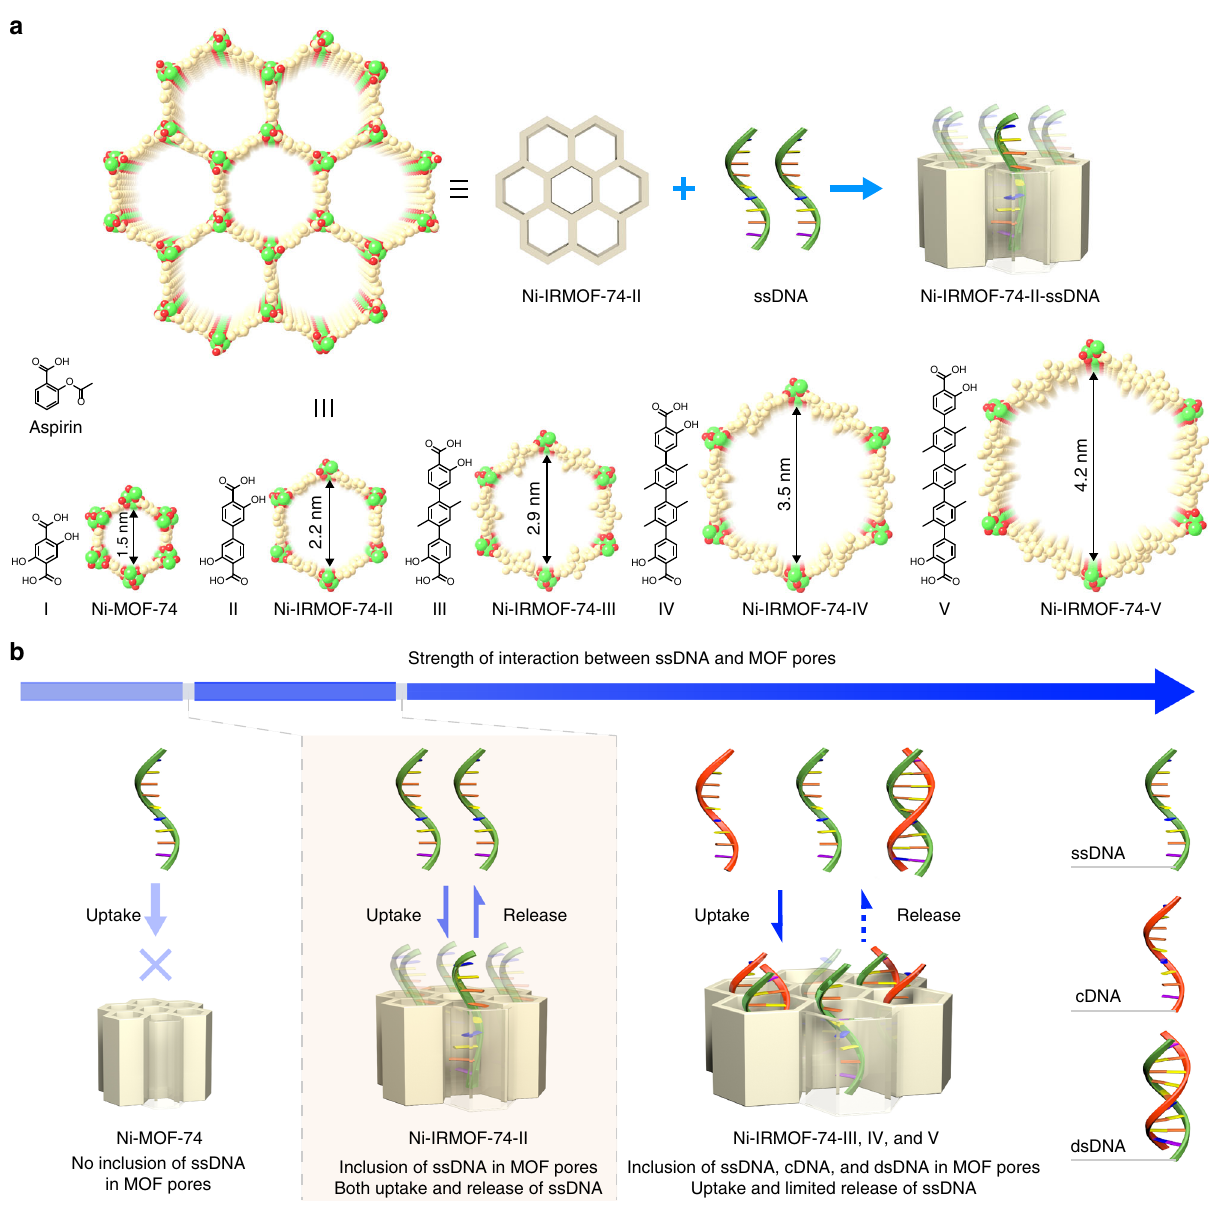
Fig. 1 Fine-tuning of interactions between ssDNA and MOFs. a Illustration of ssDNA inclusion in MOFs composed of bio-compatible organic linkers and with precisely controlled pore sizes. Ni, C, and O atoms were labeled with green, gold, and red color, respectively. b Gradual increase of interaction between ssDNA and MOFs as the pore size of MOF extended progressively. Relatively mild interactions guarantee the uptake and protection of ssDNA in the MOF pores, and also provide reversibility for their